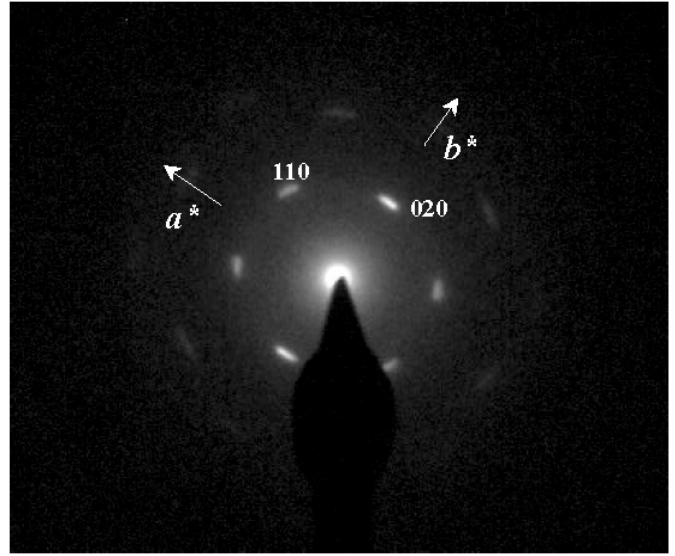
Figure 3. ( a ) Selected-area electron diffraction pattern of nylon 4 9 single crystals prepared from glycerin at 120 °C. Only the most intense hk 0 reflections are labeled. The pattern shows a clear 2 mm symmetry and reciprocal axes are labeled. ( b ) X-ray diffraction profile of a nylon 4 9 sample isothermally crystallized from diluted glycerin solution.